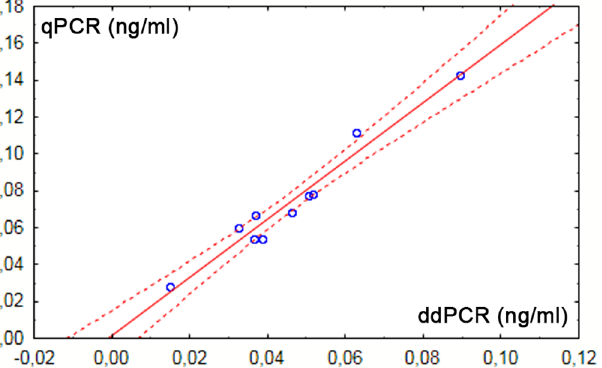
Fig 2. Correlation between measurements of cfDNA concentrations ( RHD exon 5) by both methods; r = 0.9776, p =